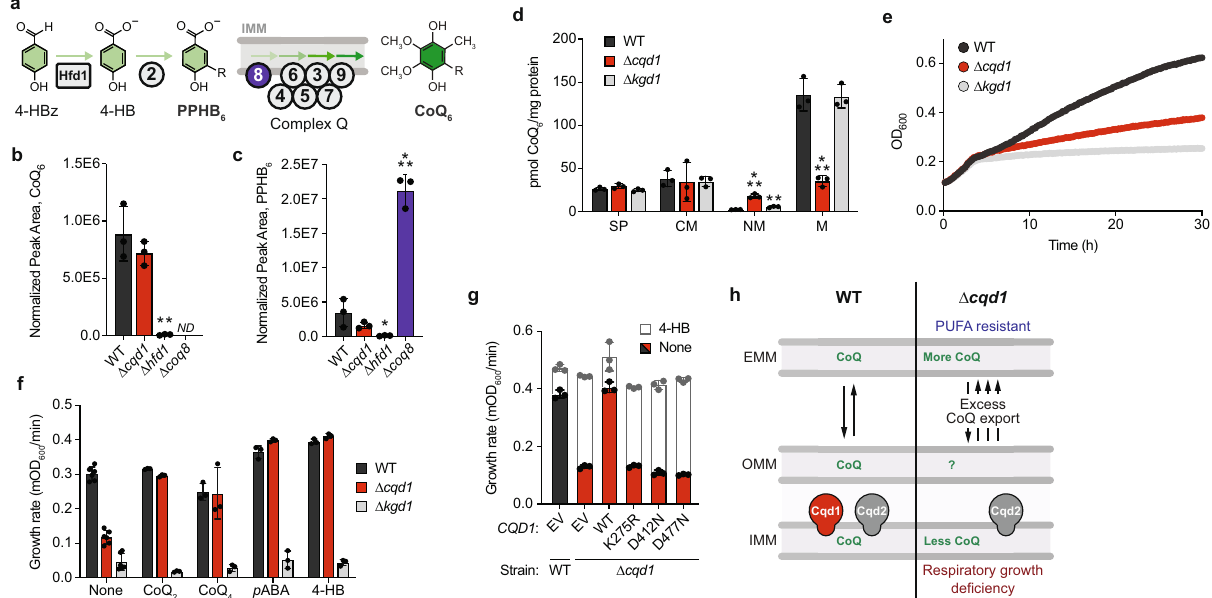
Fig. 3 Cqd1 in fl uences cellular CoQ distribution. a Schematic of CoQ biosynthesis pathway. Polyprenyl hydroxybenzoate (PPHB) is an early precursor that undergoes a series of head group modi fi cations by IMM-associated Coq enzymes (complex Q) to produce CoQ. Hfd1 is essential for PPHB synthesis, while Coq8 is required for the production of CoQ. b Total CoQ from WT, Δ cqd1 , Δ hfd1 , and Δ coq8 yeast (** p = 0.0030 WT vs Δ hfd1 ; mean ± SD, n = 3 independent samples); not detected ND. c Total polyprenyl-4-hydroxybenzoate (PPHB) from WT, Δ cqd1 , Δ hfd1 , and Δ coq8 yeast (* p = 0.0471 WT vs Δ hfd1 , *** p = 0.0006 WT vs Δ coq8 ; mean ± SD, n = 3 independent samples). d CoQ from subcellular fractions derived from WT, Δ cqd1 , and Δ kgd1 yeast (*** p = 0.0004 WT NM vs Δ cqd1 NM, ** p = 0.0029 WT NM vs Δ kgd1 NM, *** p = 0.0009 WT M vs Δ cqd1 M; mean ± SD, n = 3 independent samples). SP, spheroplast; CM, crude mitochondria; NM, non-mitochondrial fraction; M, enriched mitochondria. e Growth assay of WT, Δ cqd1 , and Δ kgd1 yeast in p ABA – media containing 0.1% (w/v) glucose and 3% (w/v) glycerol (mean, n = 6 independent samples). Yeast enter the respiratory phase of growth after ~4 h in this growth condition. f Growth rate of WT, Δ cqd1 , and Δ kgd1 yeast assayed under conditions described in ( d ) (mean ± SD; none n = 6 independent samples, all others n = 3). Yeast were grown in the presence and absence of 100 µ M CoQ analogs (CoQ 2 , CoQ 4 ) and 1 µ M CoQ precursors ( p ABA, 4-HB). g Growth rate of WT and Δ cqd1 yeast transformed with the indicated plasmids (EV, CQD1 or CQD1 , point mutants) and grown in Ura − , p ABA − media containing 0.1% (w/v) glucose and 3% (w/v) glycerol (mean ± SD, n = 3 independent samples). Yeast were treated with 0 (colored bars) or 1 µ M 4-HB (white bars, superimposed) to determine rescue of respiratory growth. h Model for Cqd1 ’ s putative role in cellular CoQ distribution. OMM, outer mitochondrial membrane; IMM, inner mitochondrial membrane; EMM, extramitochondrial membranes. b – d Signi fi cance calculated by an unpaired, two- tailed Student ’ s t